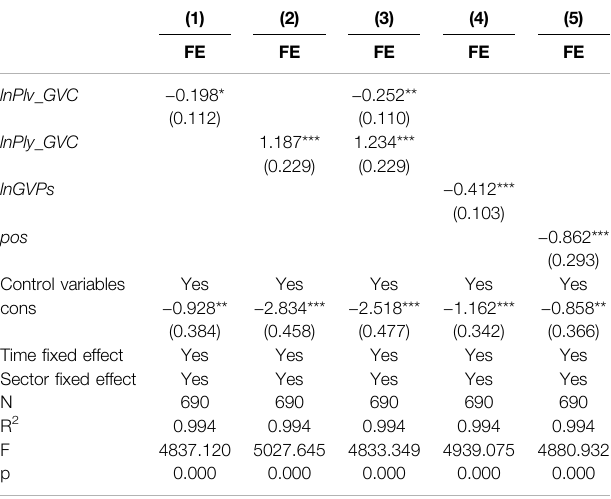
TABLE 5 | Analysis of the length of forward/backward production chains and the position in the